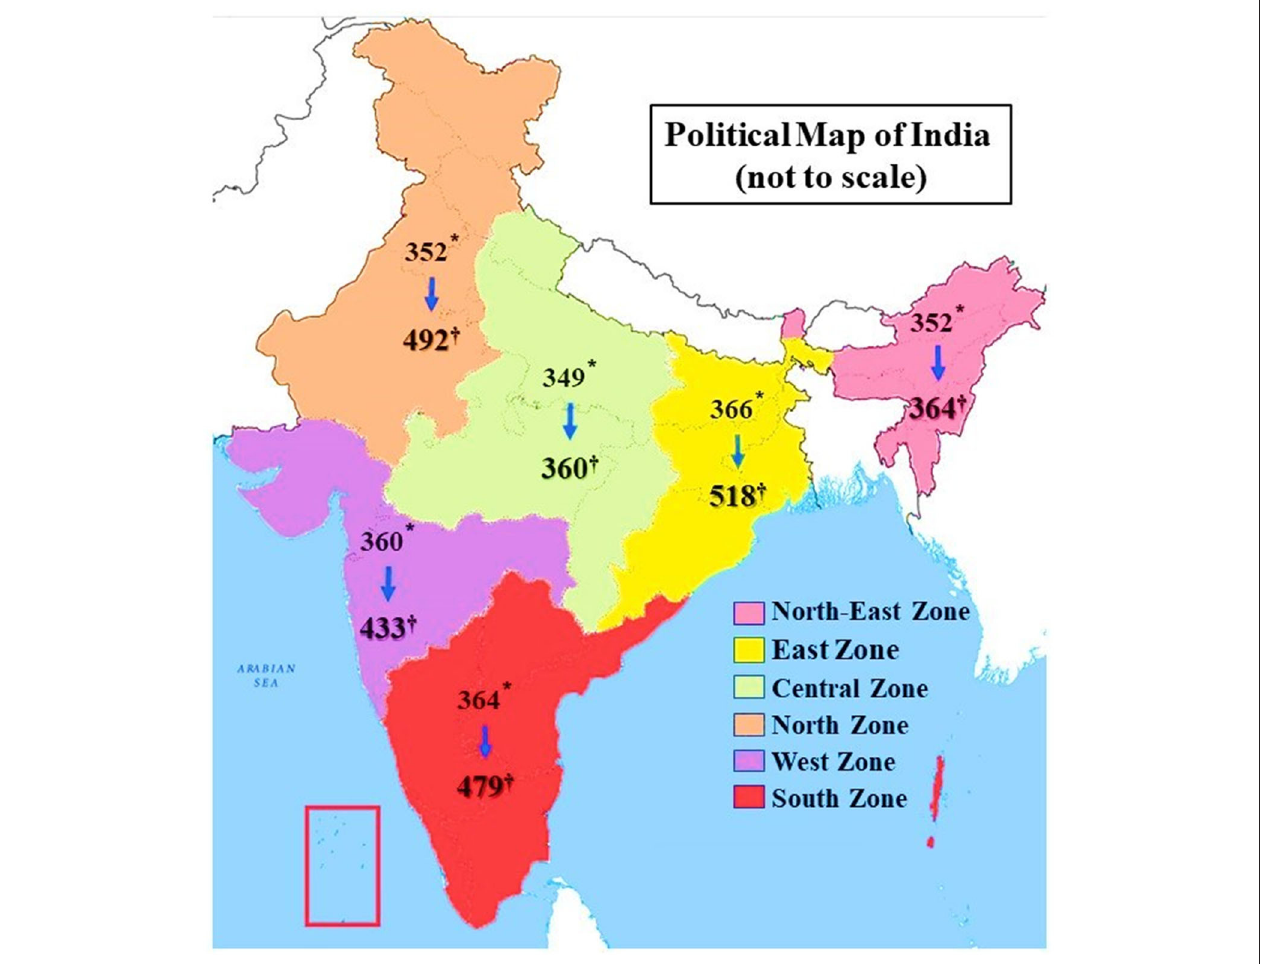
FIGURE 2 | Zones in India and participants selected from each zone. *The number of participants in the respective zone who were primarily given the data collection † form (represents only the primary respondents), Who completed and submitted the form (includes primary respondents and also those who responded through spread of the questionnaire). Both these numbers represent eligible study population only after applying inclusion and exclusion